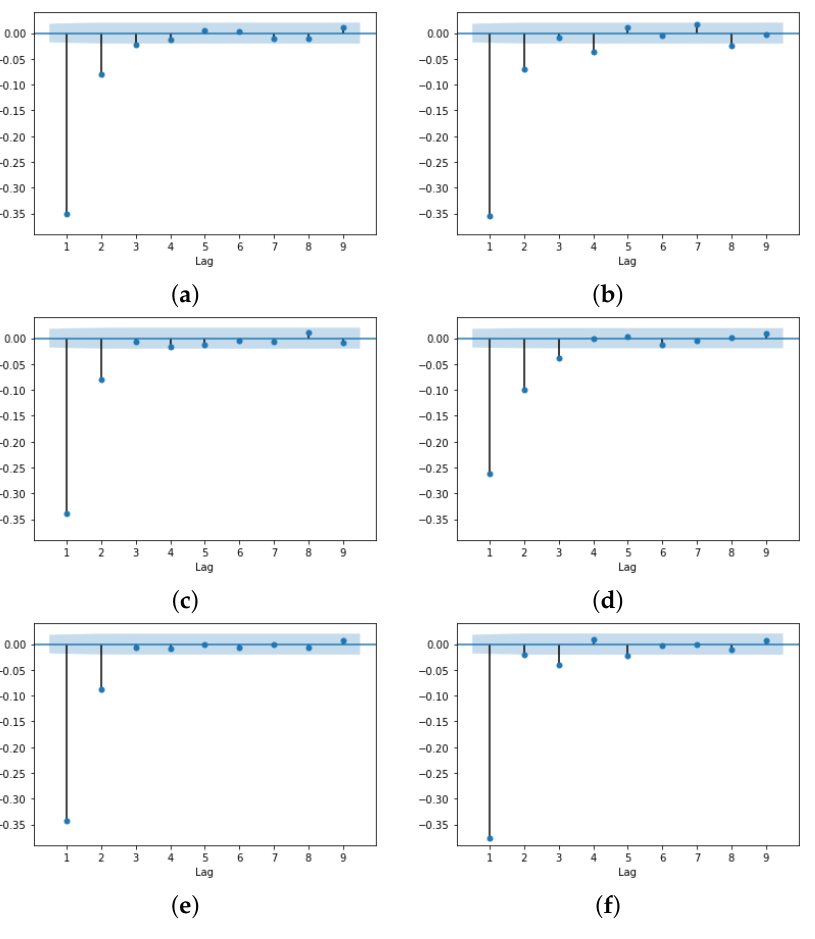
Figure 5. 2-s returns autocorrelation. ( a ) CDA. ( b ) FBA (0.5). ( c ) FBA (1.0). ( d ) HVCDA. ( e ) FBA (1.5). ( f ) FBA (2.0).